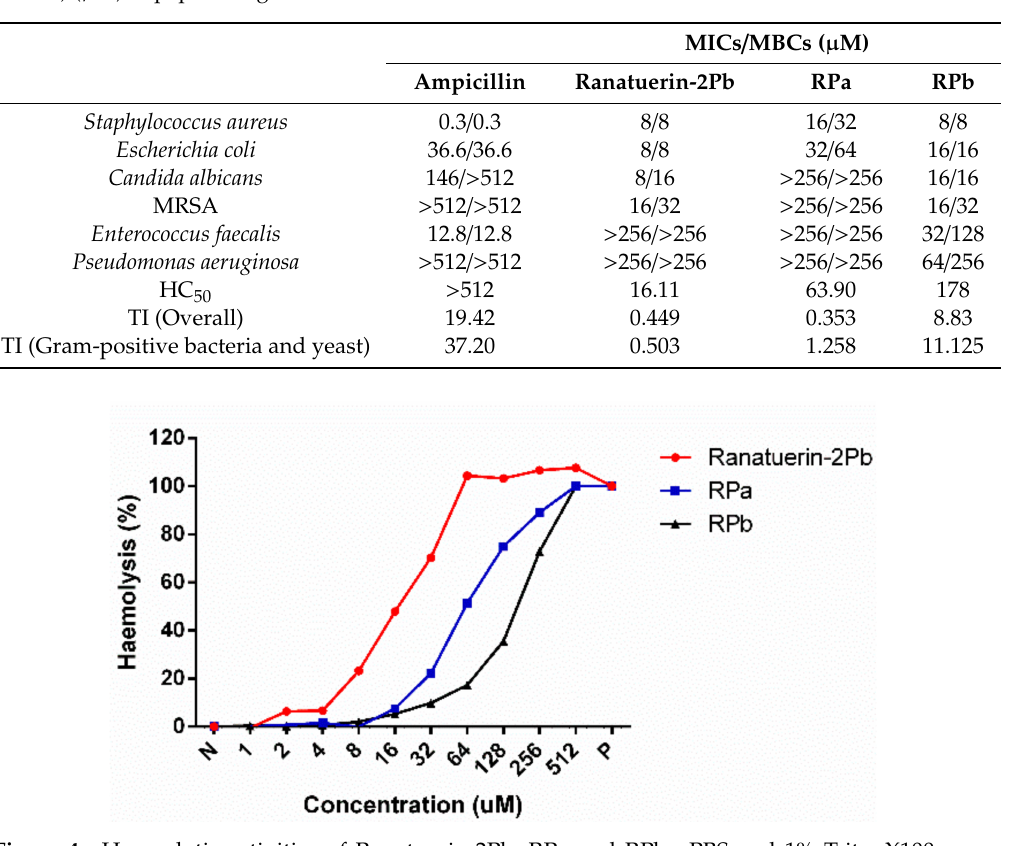
Figure 4. Haemolytic activities of Ranatuerin-2Pb, RPa and RPb. PBS and 1% TritonX100 were employed as negative control (N) and positive control (P), respectively. The 100% haemolysis was achieved by 1%